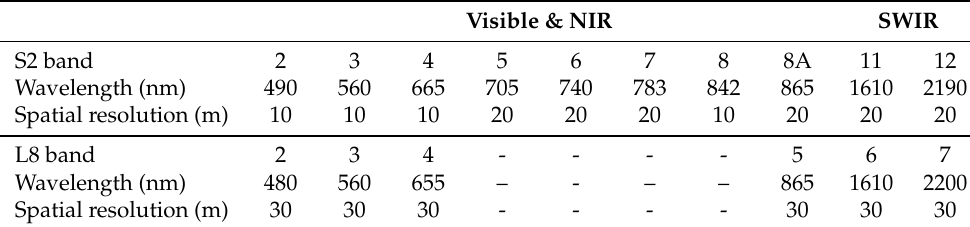
Table 2. S2 and L8 spectral